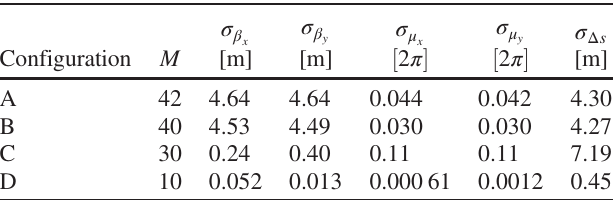
TABLE II. The standard deviation of the optics ( σ β for the x;y horizontal and vertical beta functions and σ μ for the horizontal x;y and vertical phases advance) and of the longitudinal distances between the BPMs σ Δ , for the BPM configurations A – s